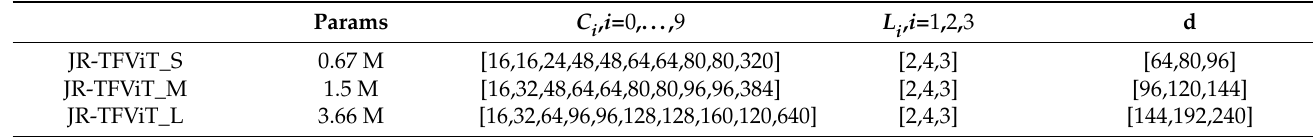
Figure 9. The JR-TFViT structure framework for radar jamming signal recognition. Table 2. Parameter settings of JR-TFViT_S, JR-TFViT_M, and JR-TFViT_L.